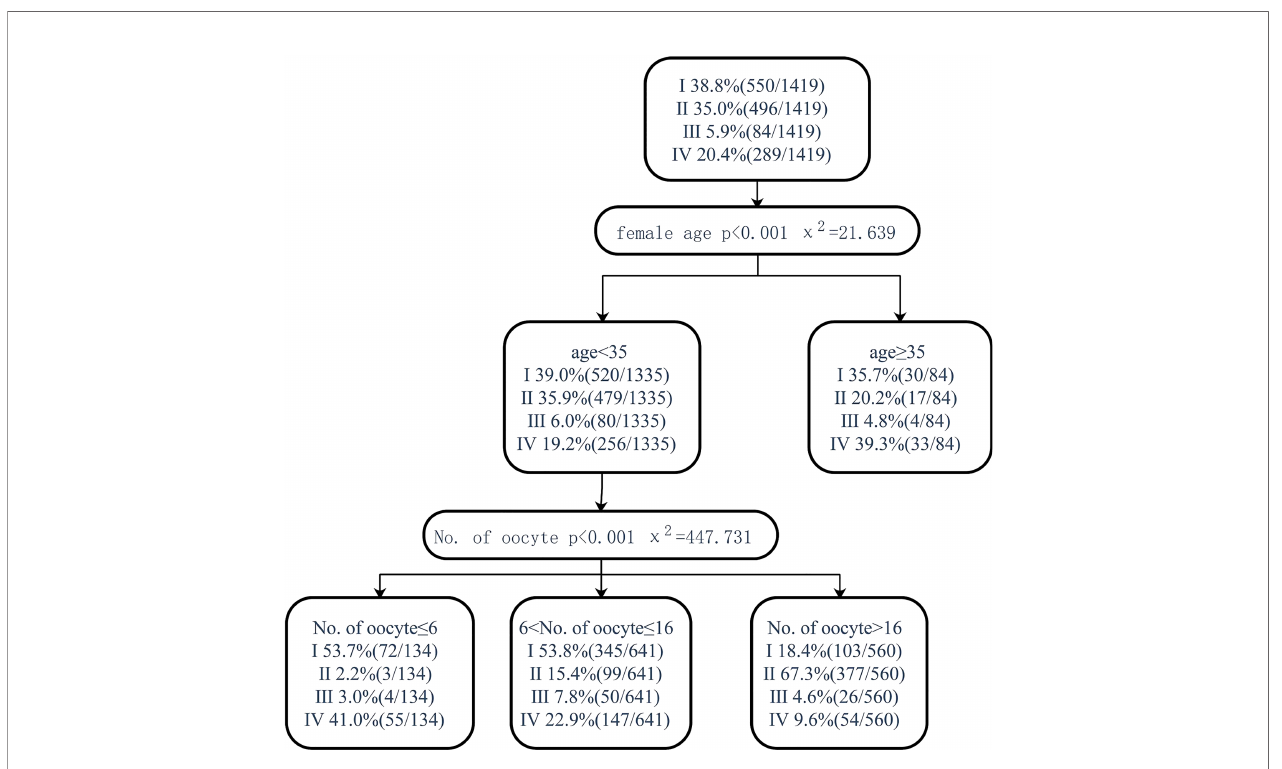
FIGURE 6 | Decision tree on live birth after fresh embryo transfer. I, live birth after fresh embryo transfer; II, live birth after the fi rst transfer using frozen embryo; III, live birth after multiple embryo transfers; IV, no live birth after embryo